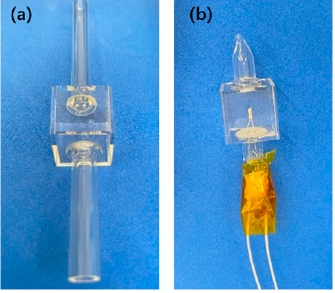
Figure 4. Temperature-measuring device. ( a ) The structure of cell. ( b ) Sealed cell, with 87 Rb and 700 torr N 2 .